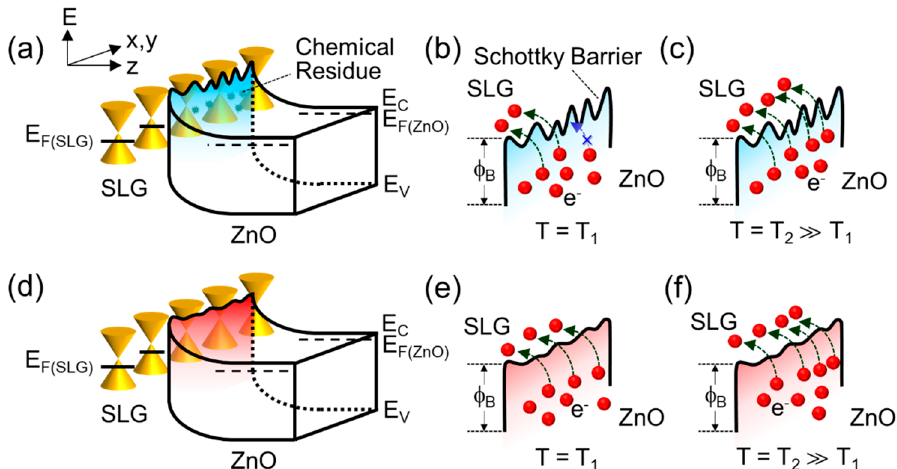
Figure 6. Expected Schottky barrier homogeneity along the in-plane direction normal to the surface and its impact on the carrier transport characteristics at different temperatures: ( a ) three-dimensional illustration of the energy-band diagram for the ZnO/SLG Schottky PD consisting of inhomogeneous Schottky barriers (e.g., for the case of the ZnO/AT-SLG Schottky PD), ( b ) carrier transport across the inhomogeneous Schottky barriers at T = T 1 , ( c ) carrier transport with TACC at T = T 2 >> T 1 for the diode with inhomogeneous Schottky barriers, ( d ) three-dimensional illustration of the energy-band diagram for the ZnO/SLG Schottky PD with homogeneous Schottky barriers (e.g., for the case of the ZnO/TC-SLG Schottky PD), ( e ) carrier transport across the homogeneous Schottky barriers at T = T 1 , and ( f ) carrier transport with TACC at T = T 2 >> T 1 for the case of the diode with homogeneous Schottky barriers.